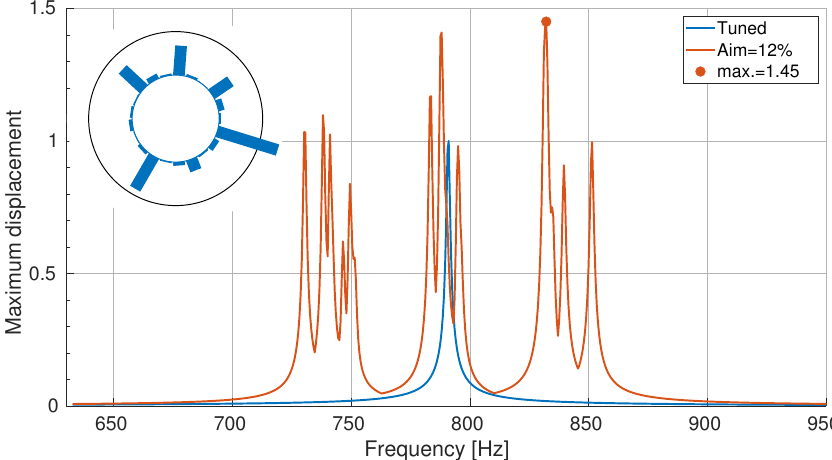
Figure 16. Frequency sweep and (inset) blade displacement at the maximum (black line corresponds to the tuned amplitude), Aim = 10%. Rotor B, [ 1,0, − 1, . . . ,1,0, − 1 ] pattern, ξ = 10 − 3